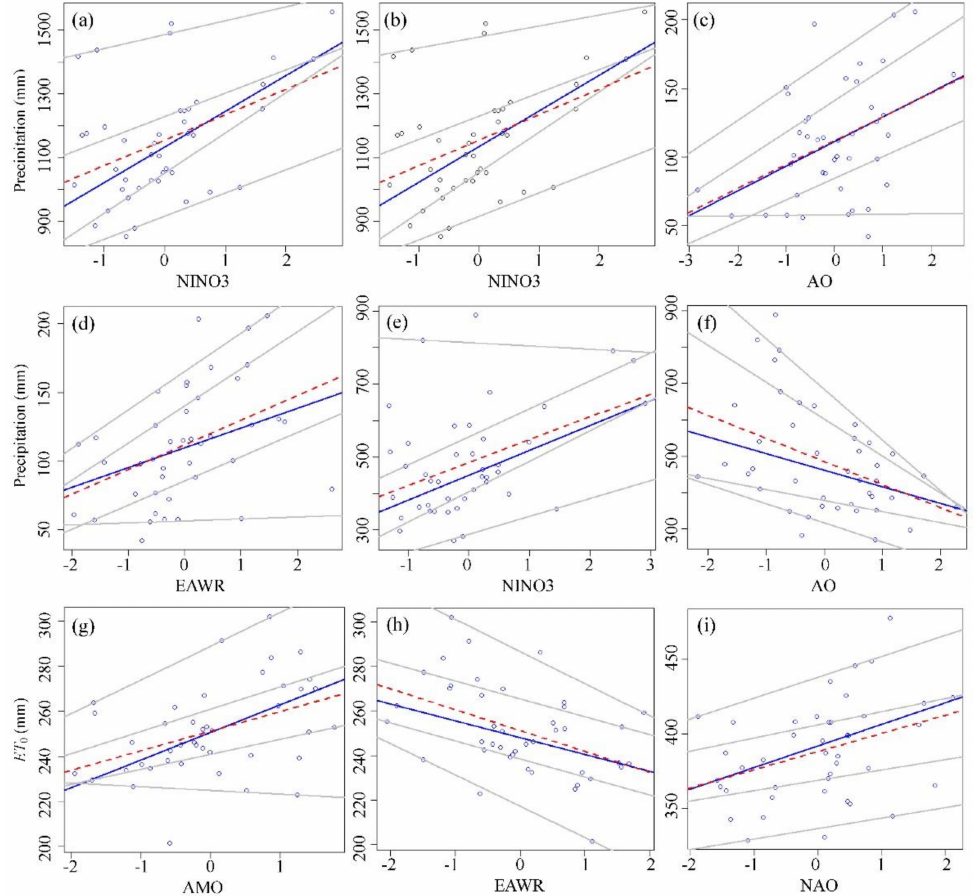
Figure 5. The regression relations between precipitation and ET 0 and climate indices. ( a , b ) repre- sented the regression relationships between annual precipitation and NINO3 index obtained by frequentist quantile regression and Bayesian quantile regression, respectively. ( c , d ) showed the correlations between winter precipitation and corresponding AO and EAWR index, respectively. ( e , f ) represented the relationships between summer precipitation and corresponding NINO3 and AO index, respectively. ( g , h ) showed the correlations between spring ET 0 and AMO and EAWR index, respectively. ( i ) represented the relationships between summer ET 0 and NAO index. ( c – i ) were derived from the frequentist quantile regression. The dashed red lines show the linear least-squares regression of the data, whereas the middle solid blue lines are the quantile regressions of the median (0.50 quantile). The solid gray lines show the quantile regression at τ = 0.05, 0.25, 0.75 and 0.95 from the bottom to the